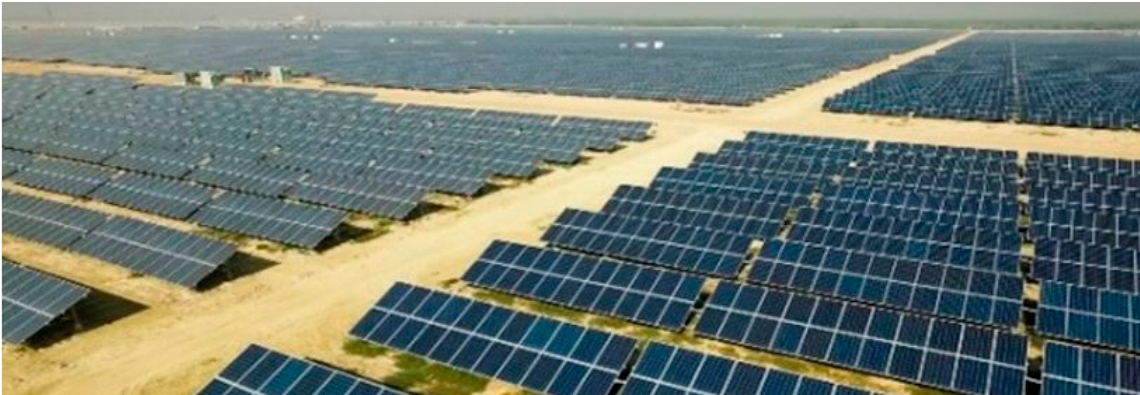
Figure 12. Quaid-e-Azam Solar Park in Pakistan [23].